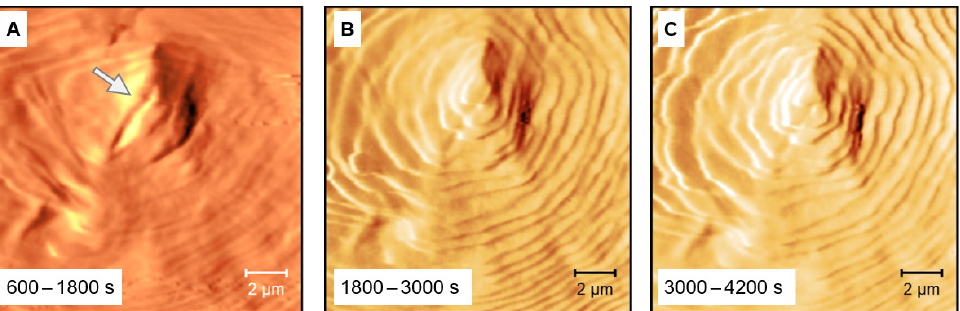
Figure 2. AFM-amplitude images of PCL collected at 330 K after tip-induced crystal nucleation and crystal growth at identical temperature. The arrow in image ( A ) indicates the positions of the first contact of the tip with the sample surface. Figure 2( A – C) were collected after 600, 1800, and 3000 s, respectively, requiring a scanning time of 1200 s each.